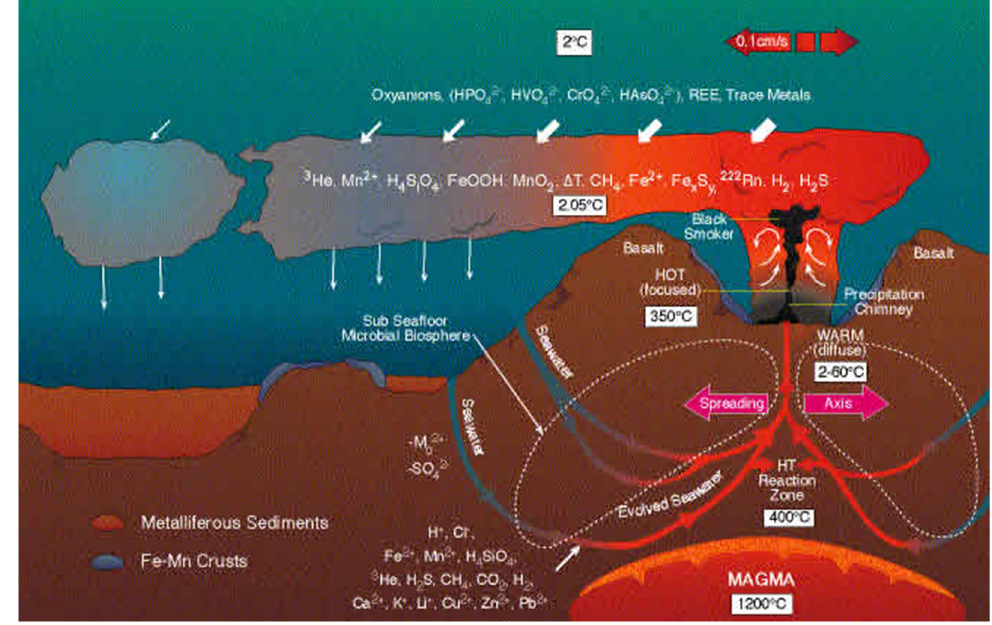
Figure 3. The hydrothermal plume [34].